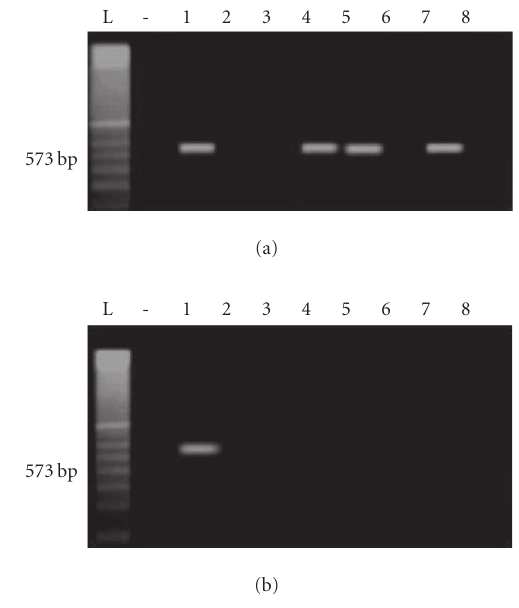
Figure 3. PCR done for the enterotoxin C gene on the 16 S au- reus isolates. (a) Lane L: 100-bp ladder; lane (-): negative control; lanes 1–8: amplicons of S aureus isolates from psoriatic patients. (b) Lane L: 100-bp ladder; lane(-): negative control; lanes 1–8: amplicons of S aureus isolates from psoriatic patients in lane 1 and from control patients following in sequential order.